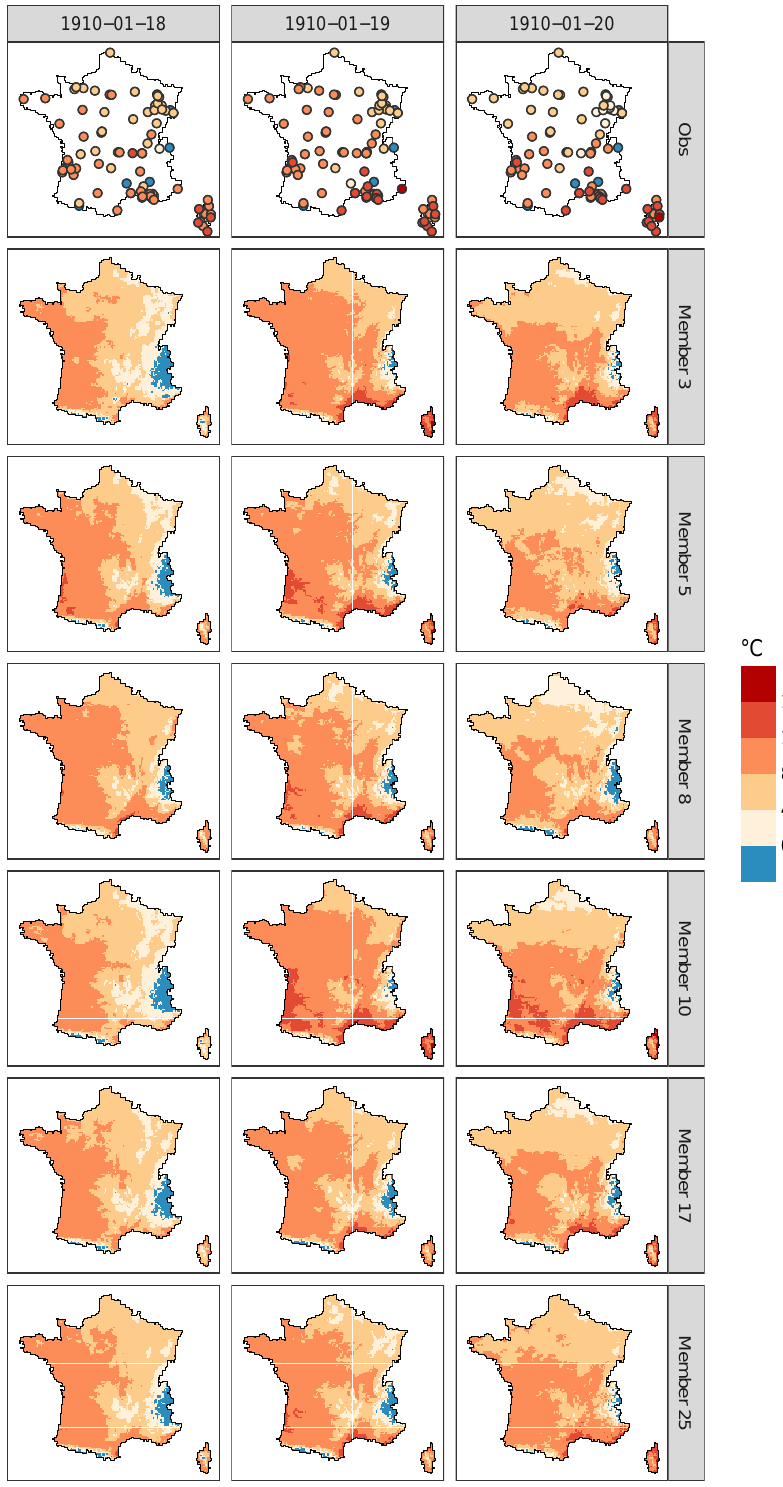
Figure 4. As for Fig. 3, but for mean